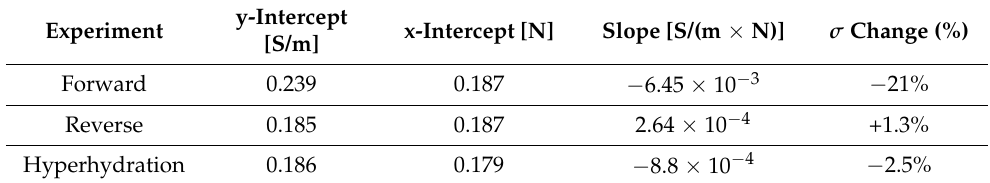
Table 3. The measured conductivity changes by − 21% and − 2.5% due to the increase of force contact for the set of samples in the forward and the hyperhydration experiment, respectively, +1.3% change is seen in the conductivity in the samples in the reverse experiment.